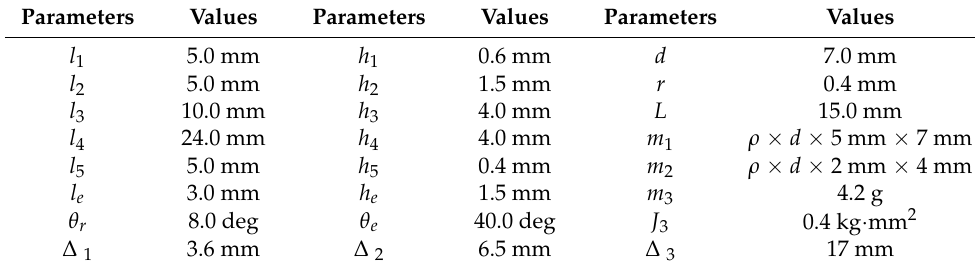
Table 3. Geometric parameters of the displacement amplification